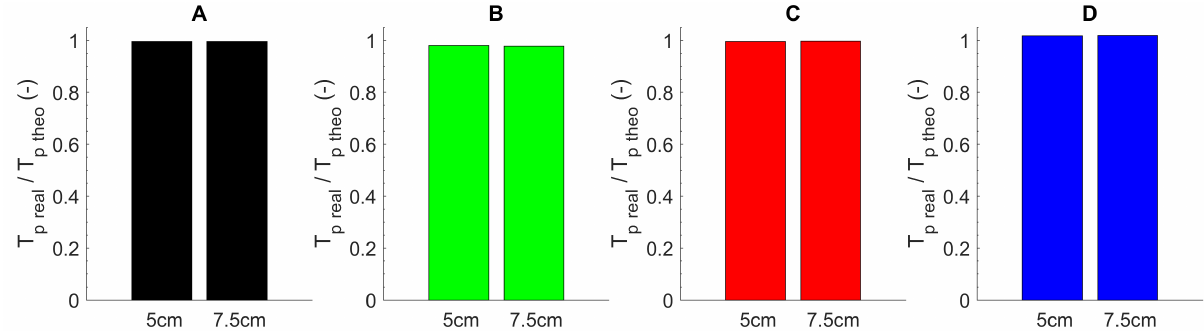
) to theoretical ( T p ) peak wave period for targeted JONSWAP T p = 1.29, H s = 5 cm and real theo